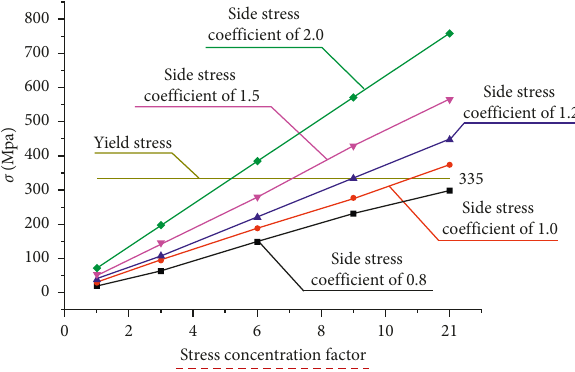
Figure 23: Vertical stress changes with different stress concen- tration factors. The black curve represents the equivalent stress of U-shaped steel with 0.8 side stress coefficient, the red curve rep- resents the case of side stress coefficient 1.0, the blue curve rep- resents the case where the side stress coefficient is 1.2, the pink curve represents the lateral stress coefficient of 1.5, the green curve represents the lateral stress coefficient of 2.0, and the brown represents the yield stress of U-shaped